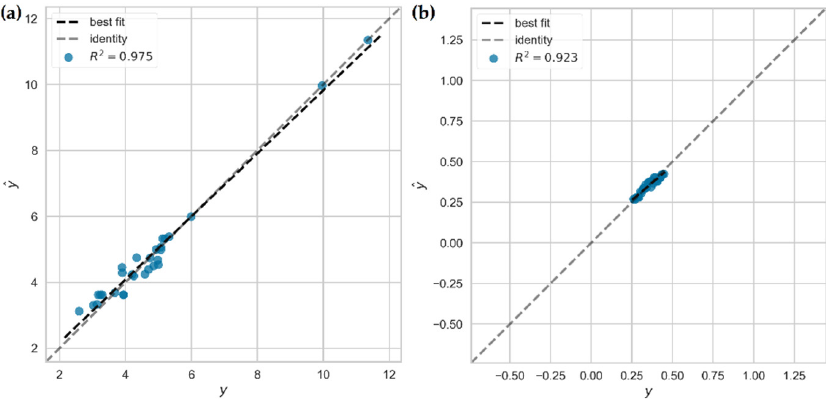
Figure 11. Experimental versus AdaBoost regression predicted ( a ) MRR ( b ) Kerf.